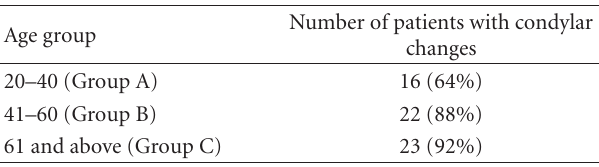
Table 4: Distribution of various radiographic findings among three age